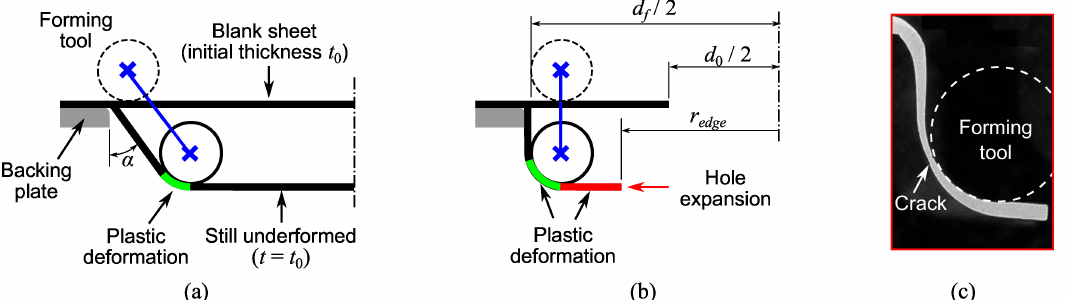
Figure 2. Schema of axisymmetric part deformation by SPIF of ( a ) inclined-wall part and ( b ) hole-flanged part; and ( c ) fractography of the failure zone for an interrupted hole-flanging test